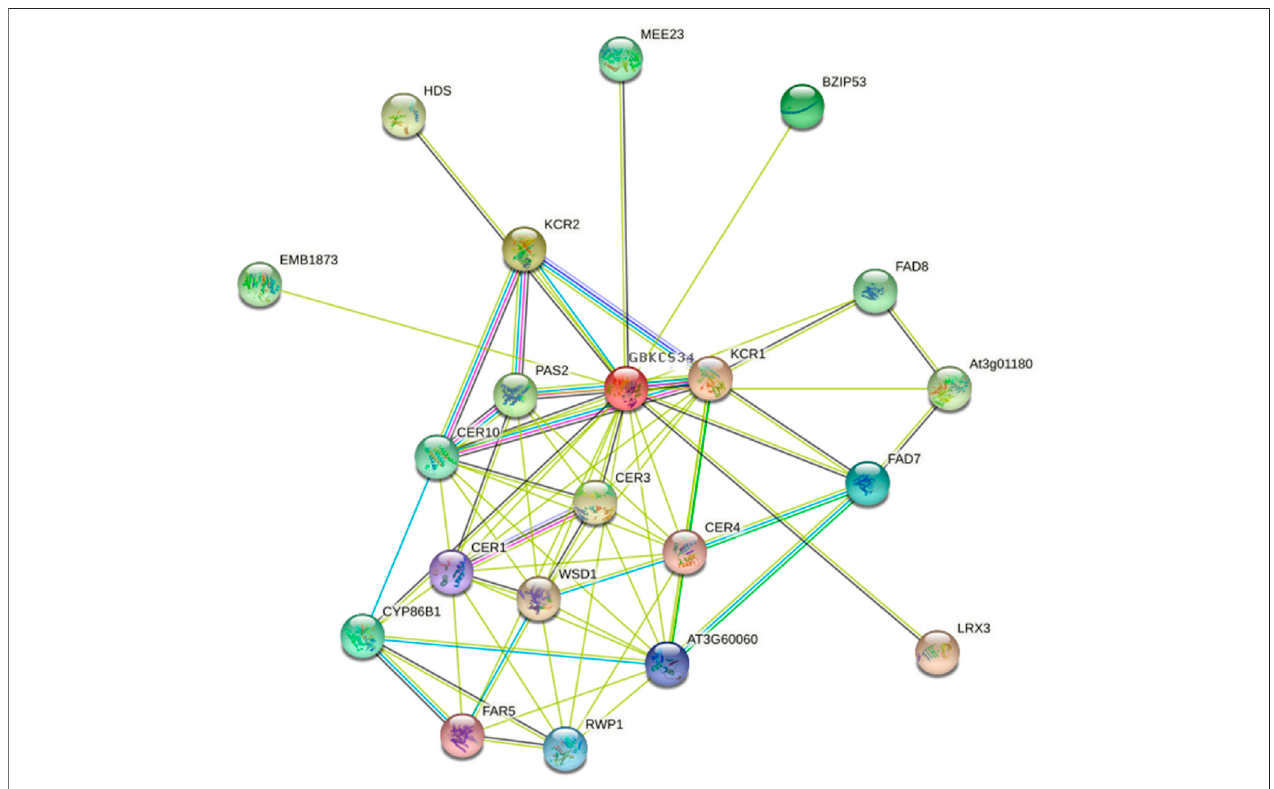
FIGURE 10 | Interaction network of GBKCS